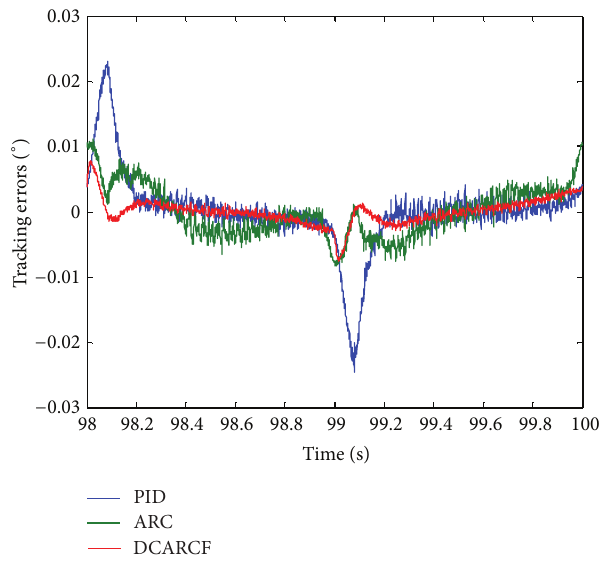
Figure 13: Tracking errors of three controllers during the last cycle in slow tracking